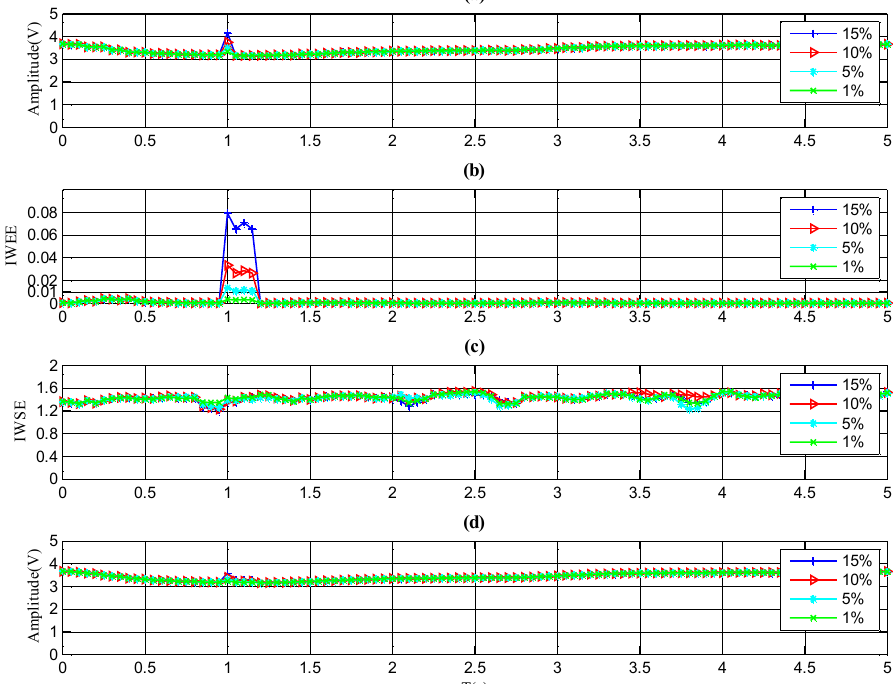
Figure 4. Results for the sensor with pulse faults. (a) Signal of sensor with pulse faults. (b) IWWE of the signal. (c) IWSE of the signal. (d) A